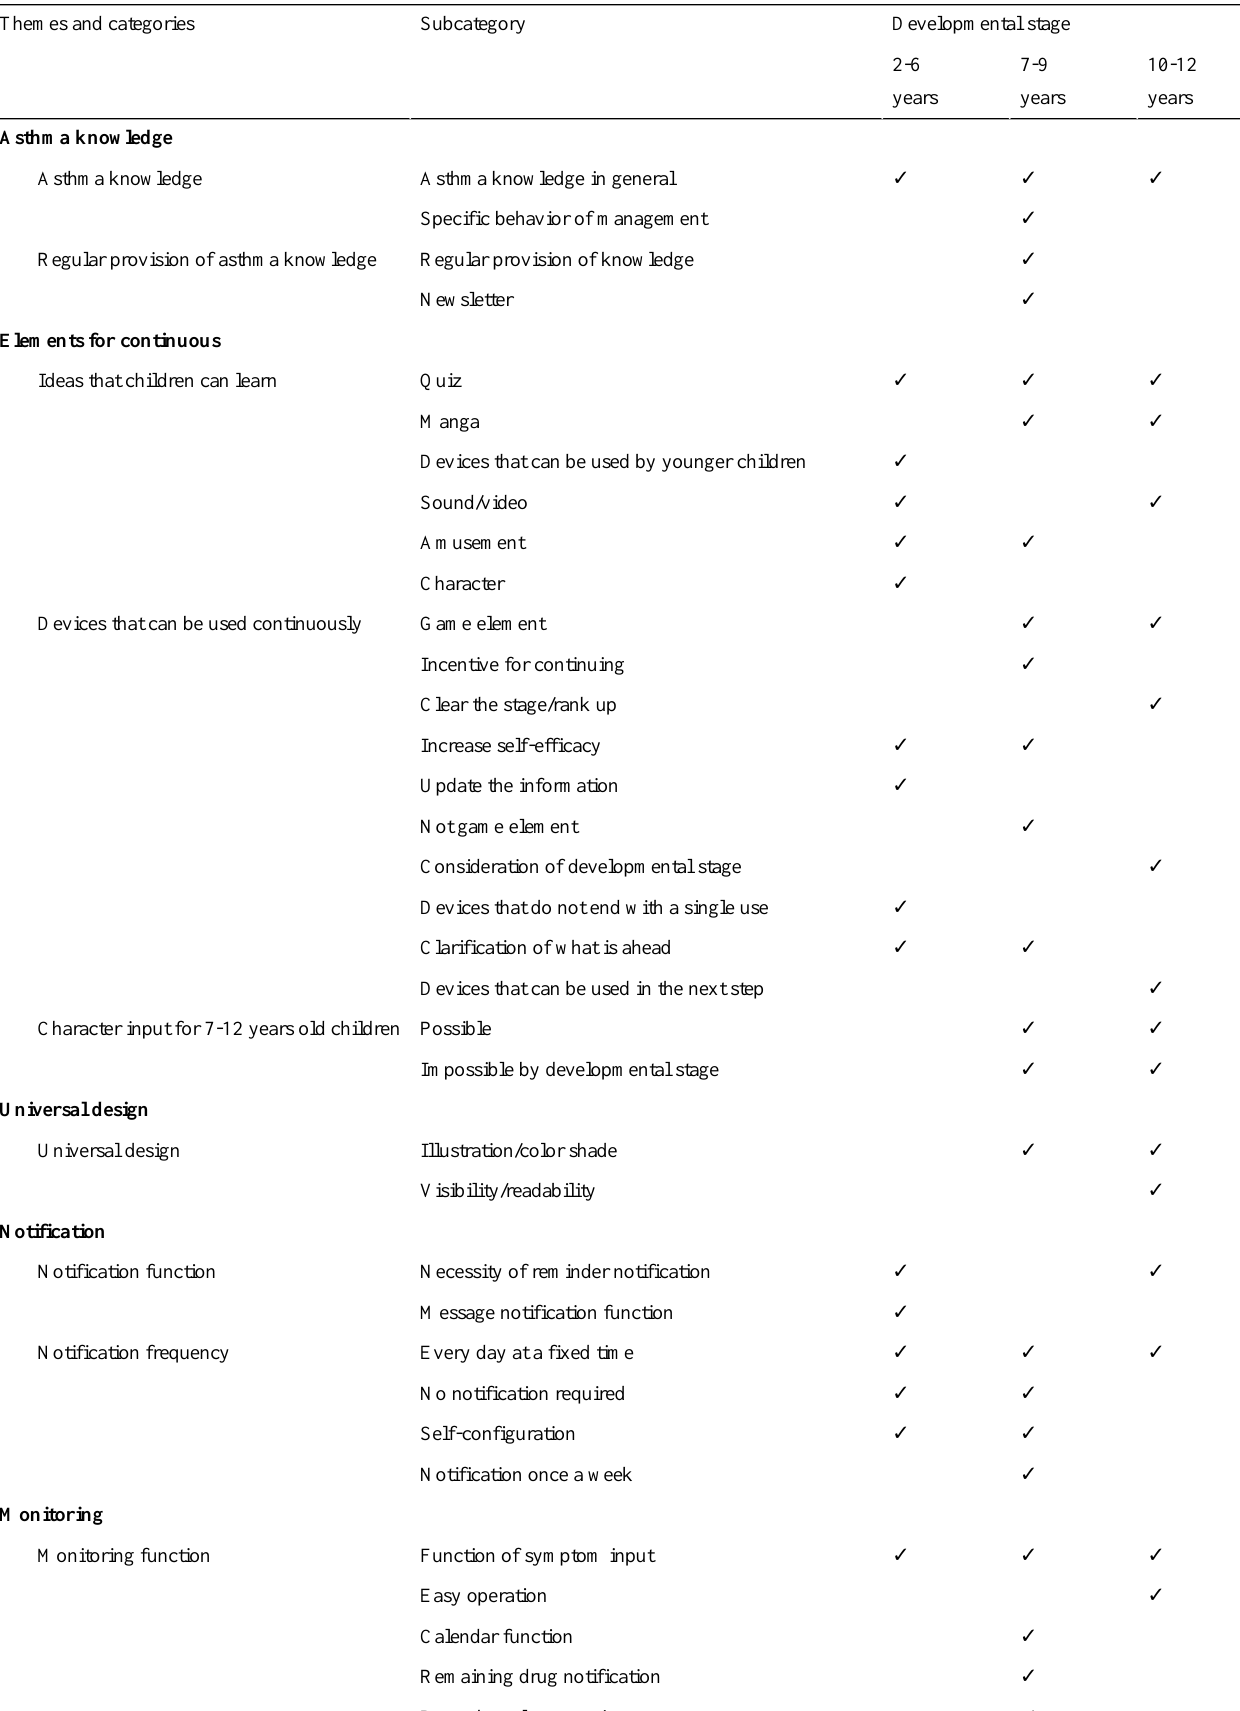
Table 4. Proposed beneficial features for the app in children with asthma and caregivers.